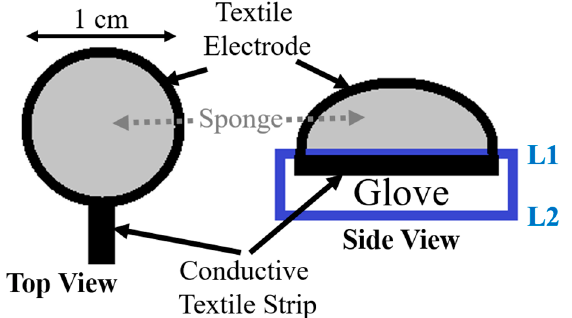
Figure 7. Schematic view of a manufactured final textile electrode.